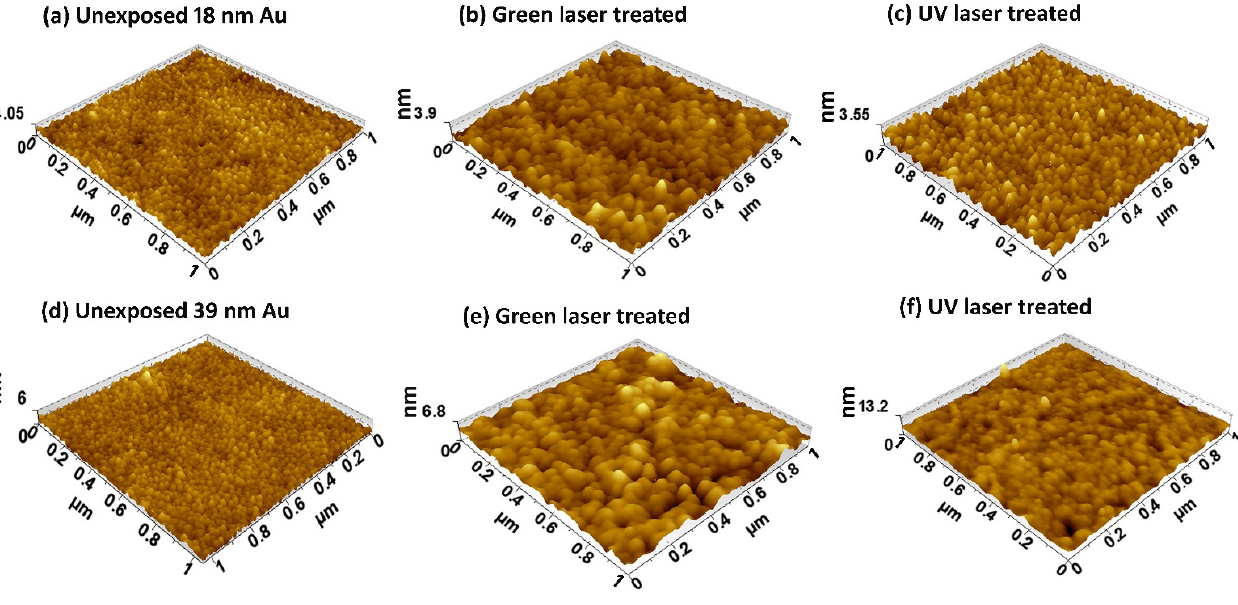
Figure 5. Topographic AFM images of ( a ) as deposited 18-nm thick Au film and ( b , c ) after laser scanning while ( d ) is as-deposited 39-nm thick film and ( e , f ) are after scanning with green and UV laser pulses, respectively.